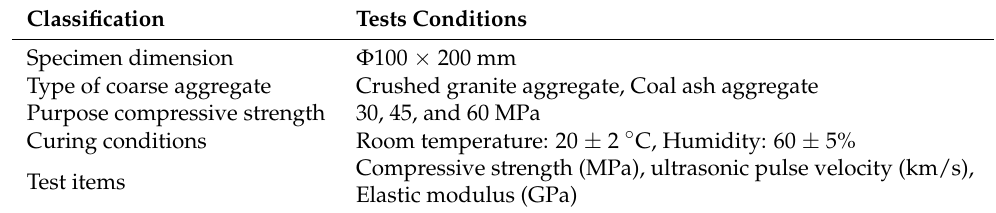
Table 4. Experimental